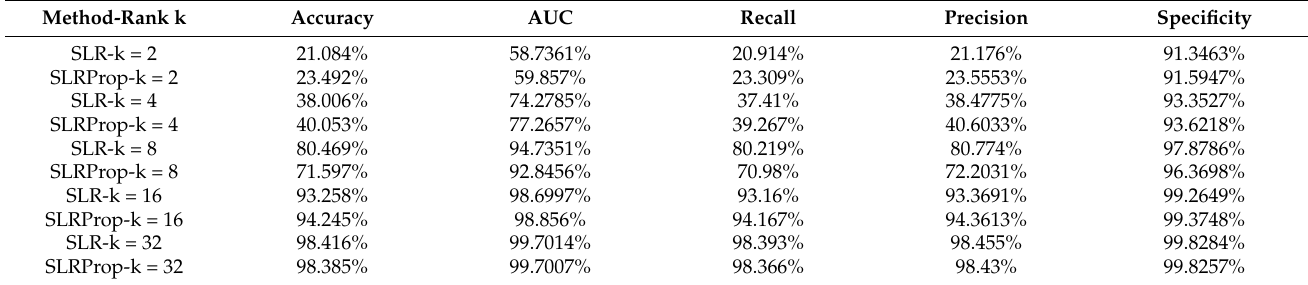
Table A3. SLR vs. SLRProp